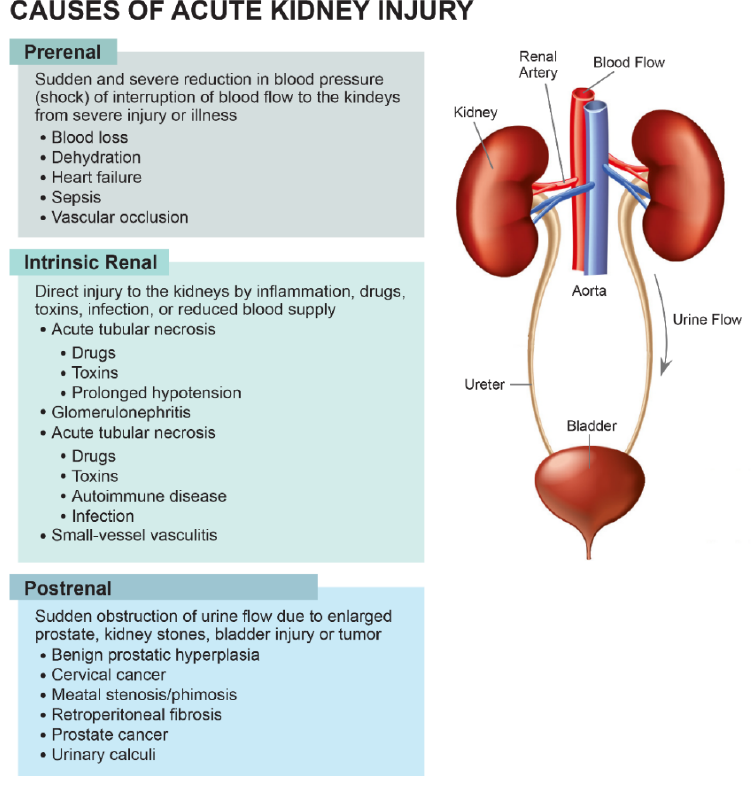
Figure 2. Causes of AKI. Table 2. Reported incidence of AKI is different among different patient populations [6–11,59,65,70,72,89–104].